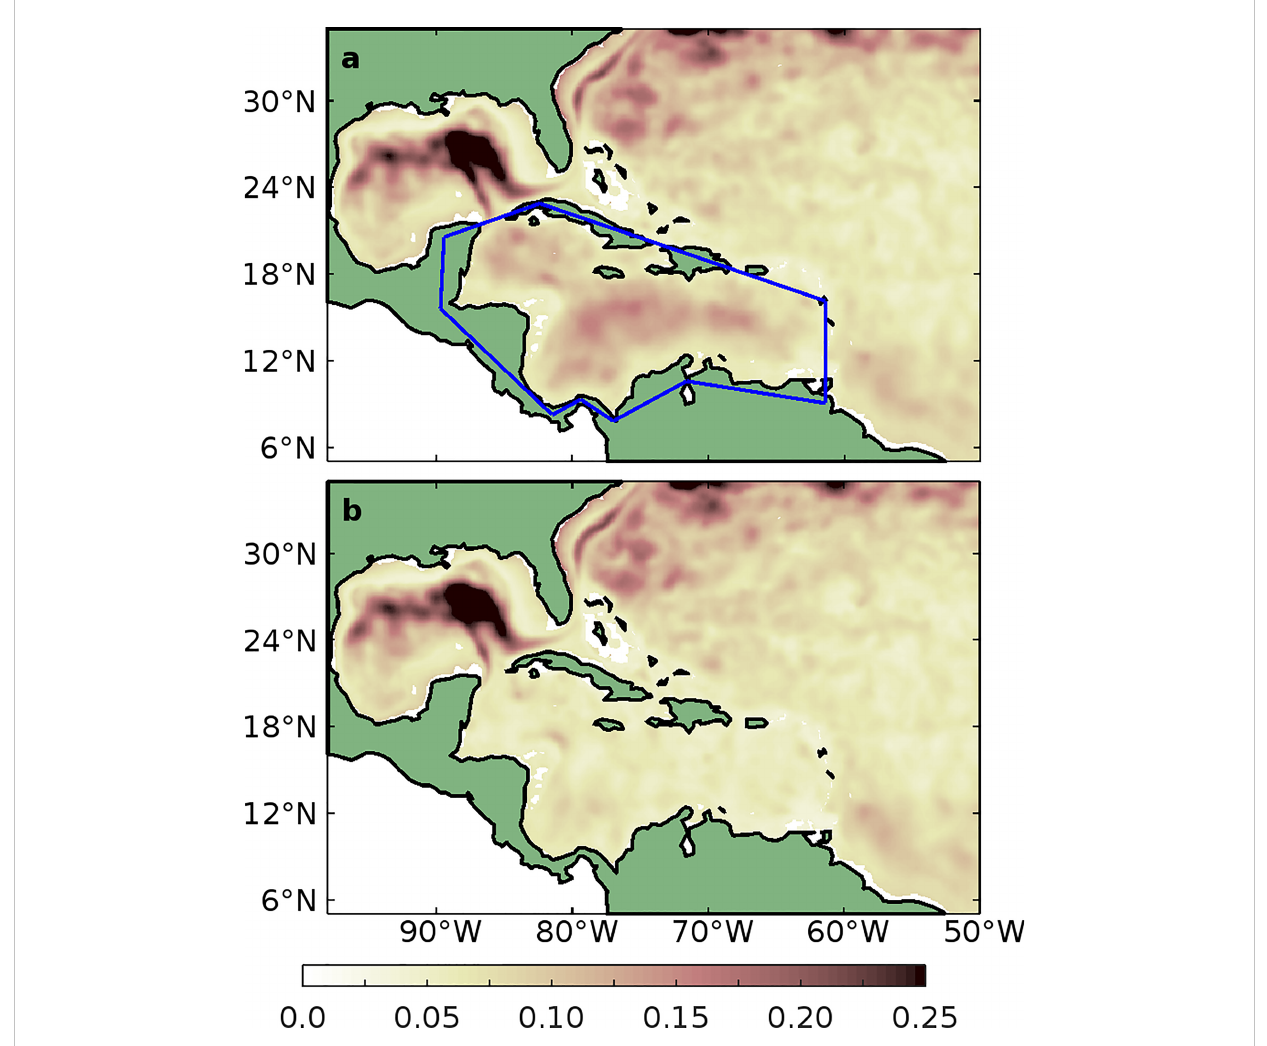
FIGURE 2 Temporal standard deviation in simulated Sea Surface Height (SSH, in meters) in the: (A) Ref and (B) NoCarib experiments during 2015. The blue box in (A) represents the extent of the Caribbean Sea in which the only assimilated observations in the NoCarib experiment were climatological SSH data. Please see text for details about the Ref and NoCarib